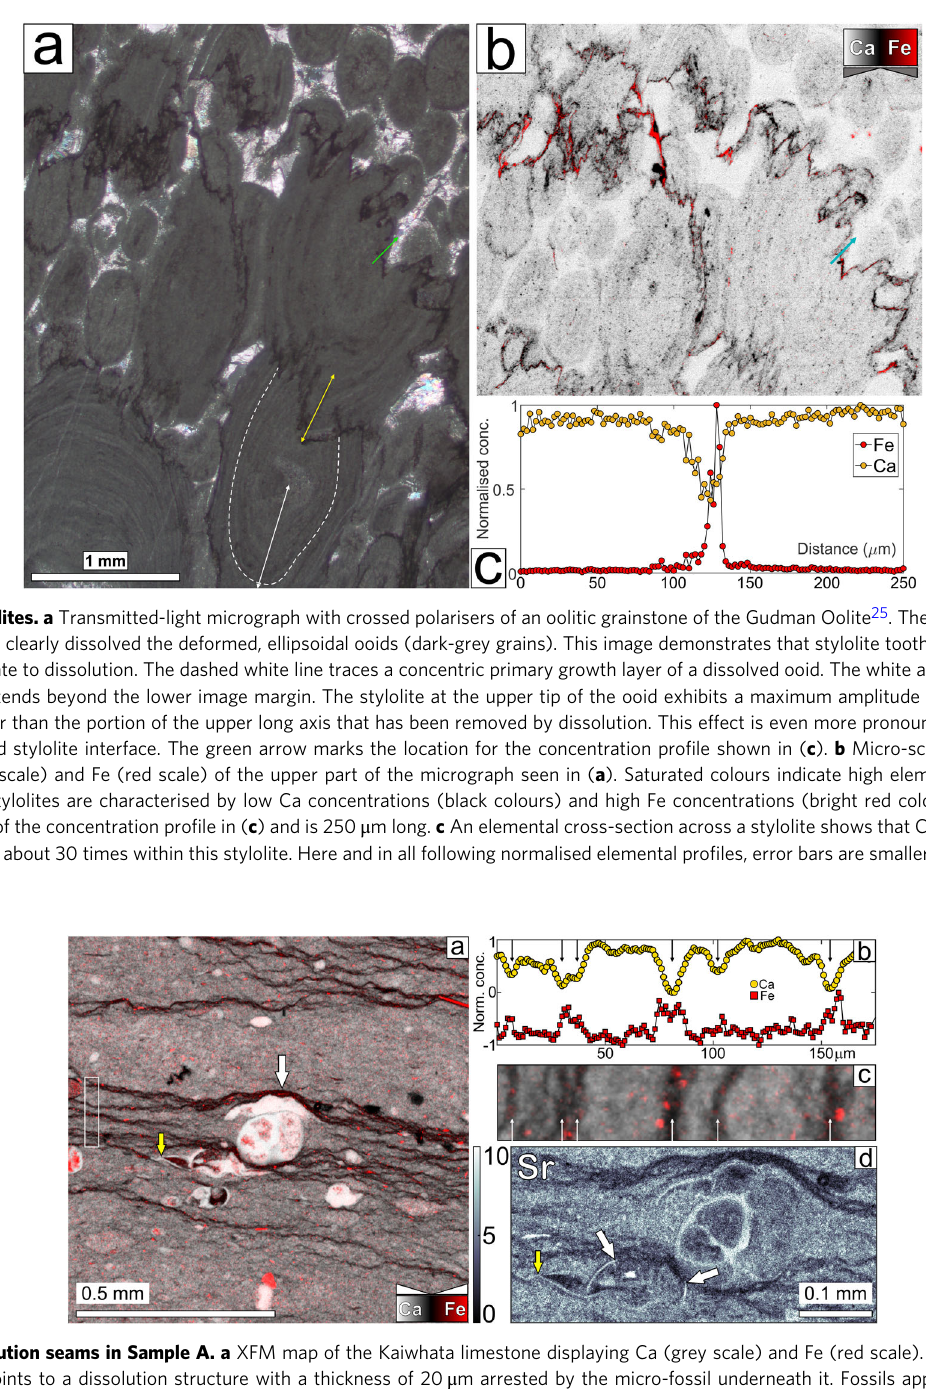
as discussed in detail further below.